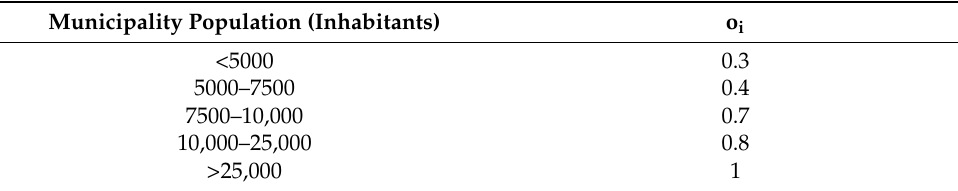
Table 3. Occlusion index o i used in the calculations with Equation